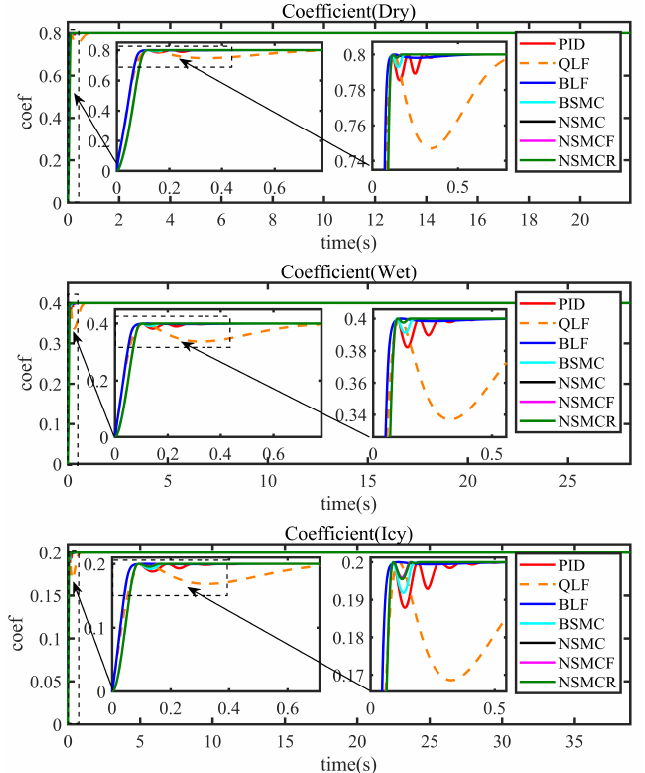
Figure 8. Simulation results of the host wheel and ground bond coefficient.